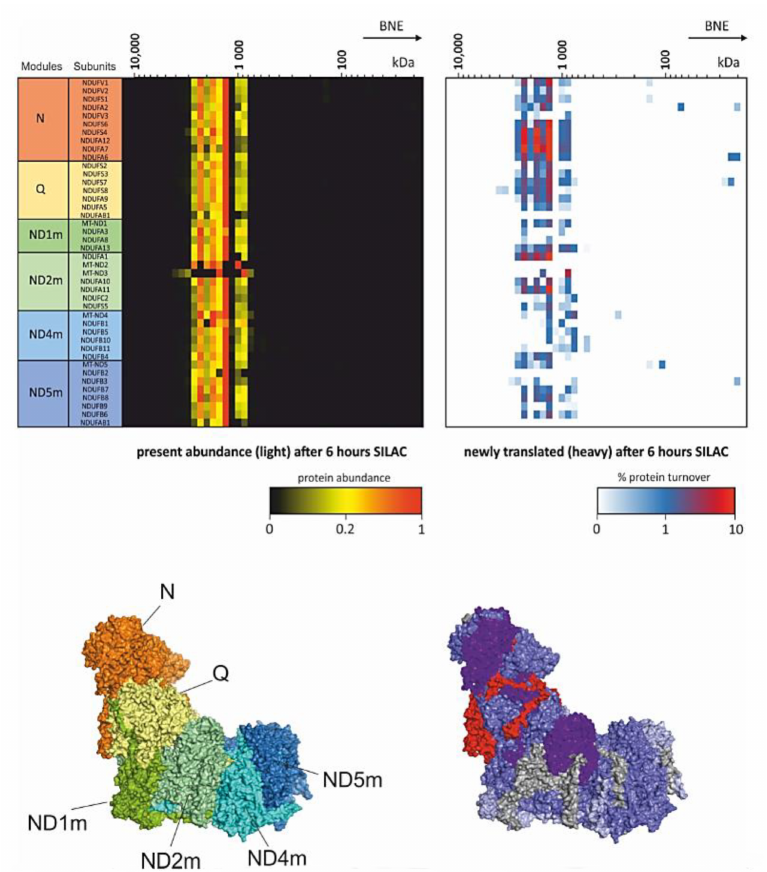
Figure 2. pSILAC Complexome profiling. Mouse myocytes were differentiated into myotubes and incubated for 6 h with SILAC medium. Heatmaps ( upper panel ) show the present light labeled complex I subunits ( left ) and the portion of exchanged newly translated heavy subunits ( right ). Lower panels indicate the modules of complex I ( left ) according to Formosa et al. [73] and the turnover of subunits ( right ) within the mouse complex I structure [66,76]. These complexome profiling data originally used in [19] were reanalyzed from PRIDE PRoteomics IDEntifications (PRIDE) archive database identifier PXD017465